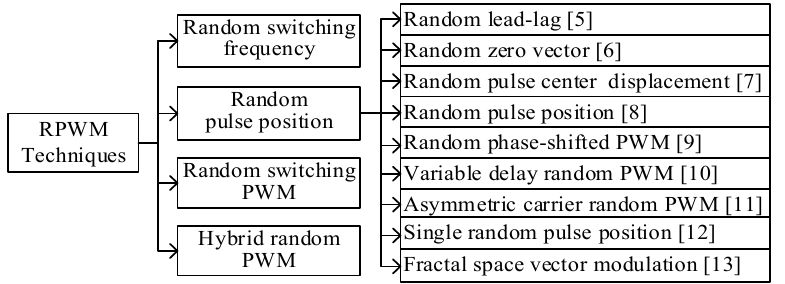
Figure 1. Random pulse width modulation (PWM) techniques.